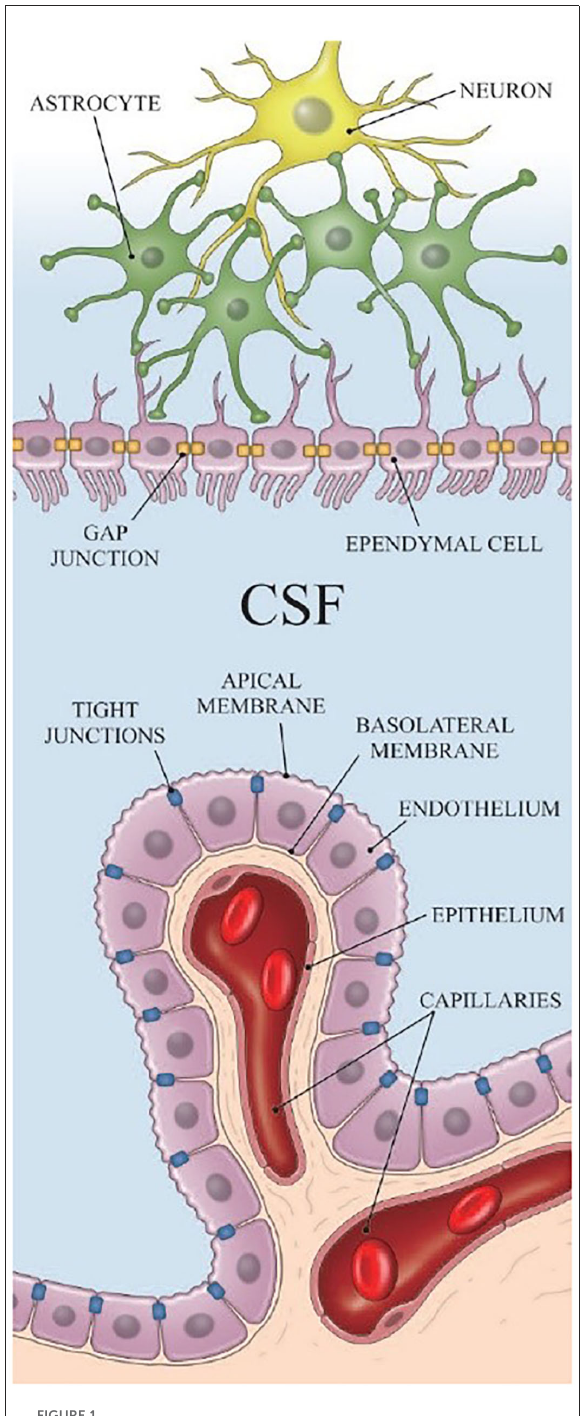
FIGURE1 The structure of the ependyma [Reproduced from Nakada et al. (18) with permission from the publisher].